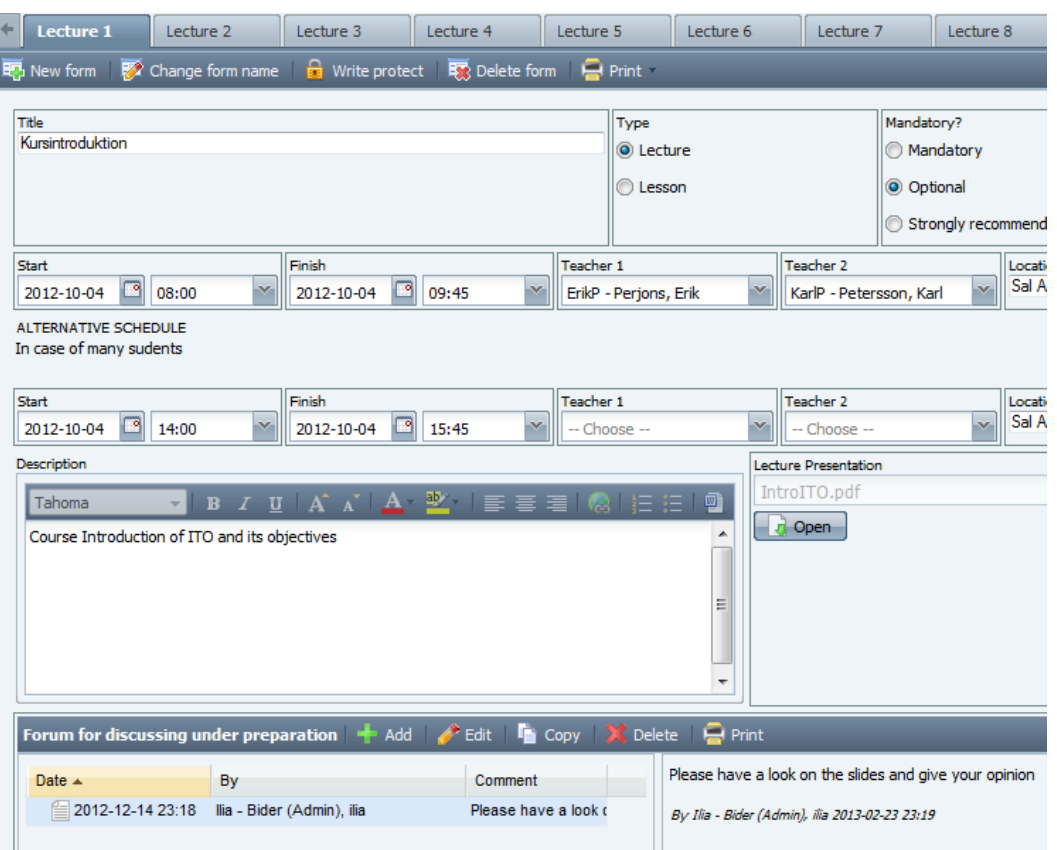
Figure A3. Step form for step Lectures/Lesson preparation from Figure A2